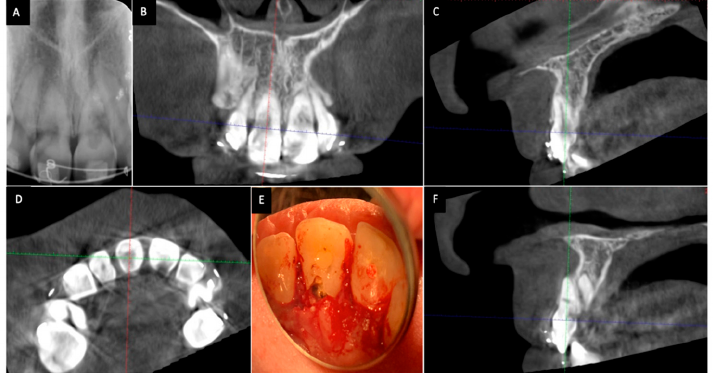
Figure 1. Cone-beam computed tomography (CBCT) shows a more accurate assessment of invasive cervical resorption (ICR) lesions than two-dimensional radiographs. The size and locations of ICR lesions can be determined with CBCT. ( A ) Periapical radiograph showing ICR lesions in maxillary right and left incisors; ( B ) The coronal view of CBCT scan image showing ICR lesions in maxillary right and left incisors;( C ) The sagittal view of CBCT scan image (maxillary right incisor); ( D ) The axial view of CBCT scan image showing the ICR lesion in maxillary right and left incisors; ( E ) Clinical view of ICR lesions located on the palatal surface of the teeth; ( F ) The sagittal view of CBCT scan image showing the ICR lesion in maxillary left incisor.